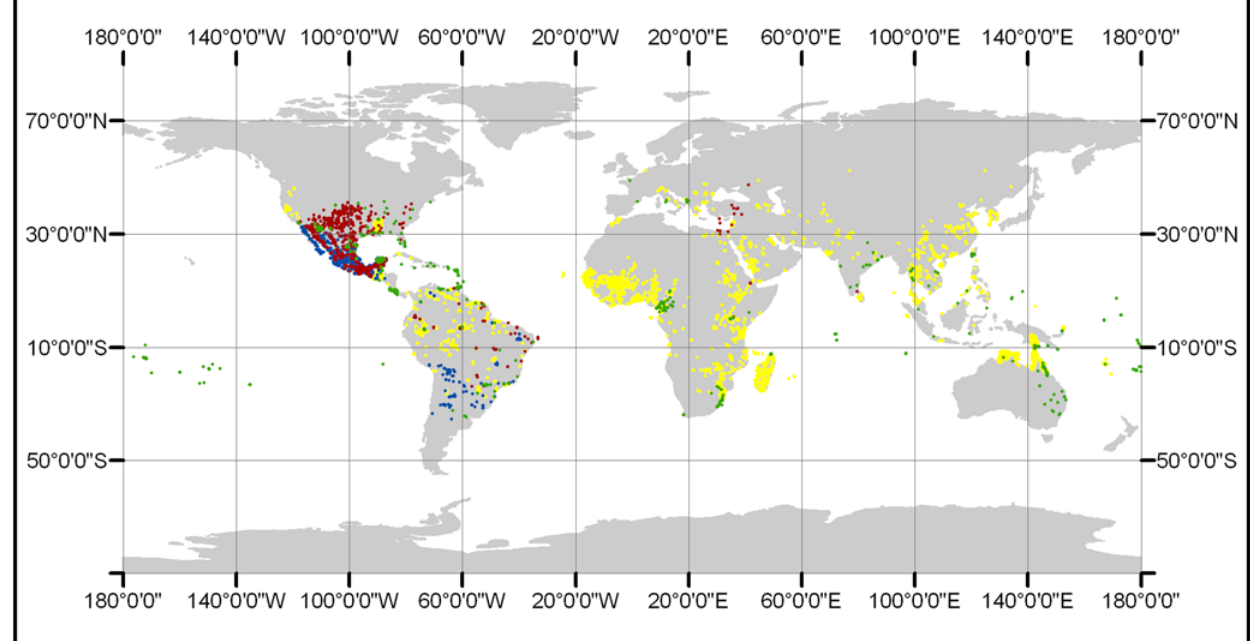
Figure 1. The distribution of vector occurrence data currently contained in the Disease Vector Database. Yellow, malaria vectors; green, dengue vectors; blue, Chagas reservoirs and vectors; red, leishmaniasis reservoirs and vectors.